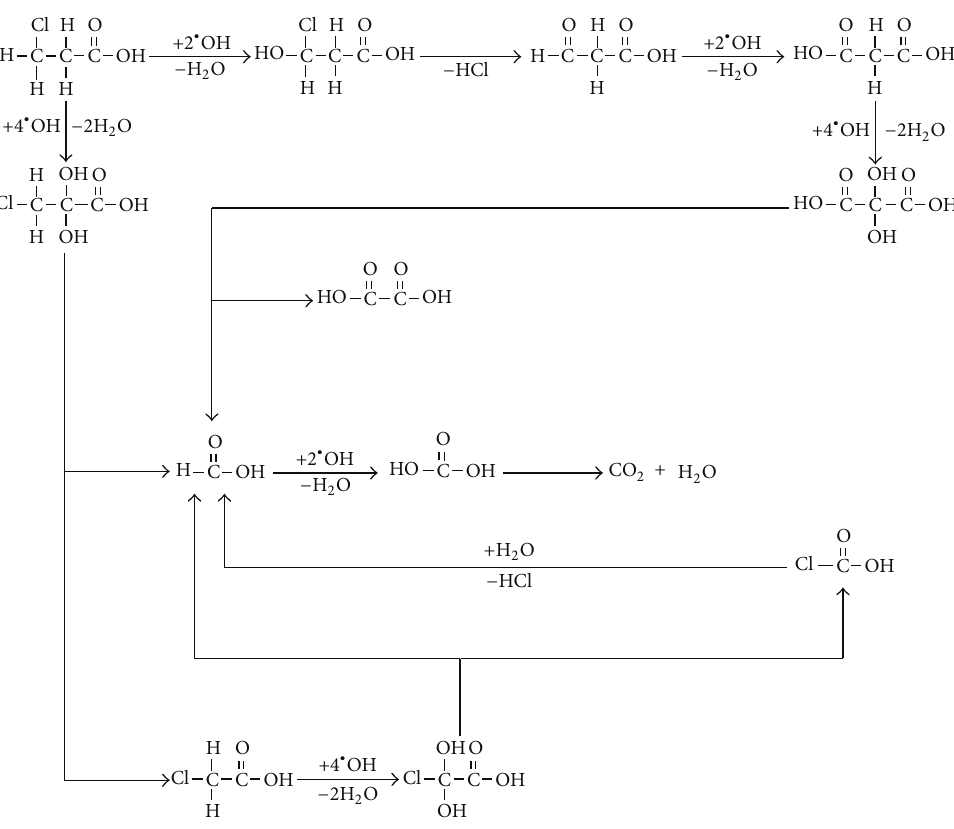
Scheme 1: Possible decomposition pathway for 3-MCPA by CGDE.